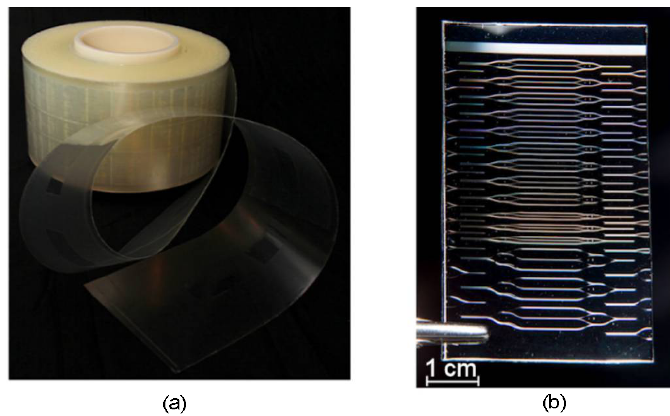
Figure 32. ( a ) Roll of the manufactured sensor by roll-to-roll processing and ( b ) sensor chip cut from the roll [92]. Copyright 2016